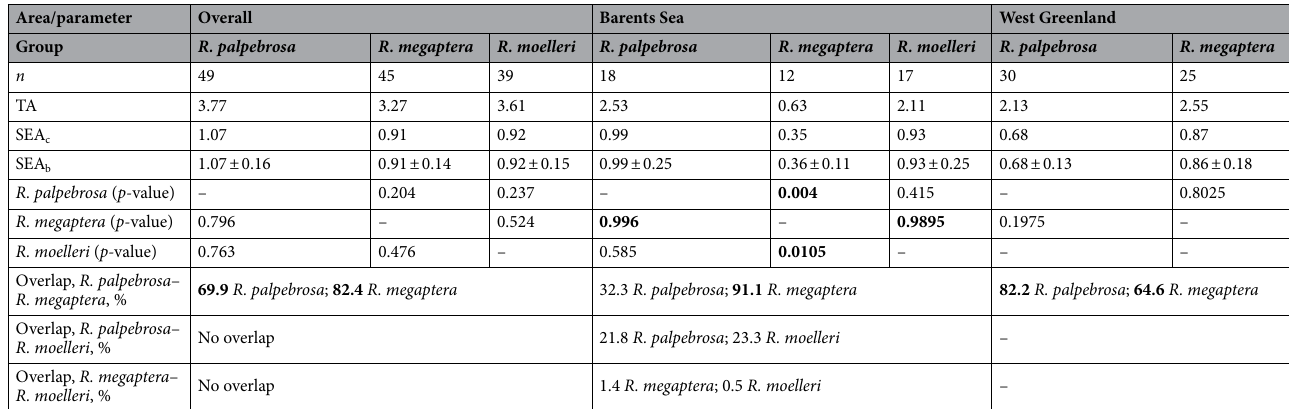
Table 3. Isotopic niche metrics (TA, SEA c and SEA b ) for the studied species of the genus Rossia in each studied area and for pooled data, and respective differences in niche widths ( p value), and niche overlap. SEA b values are means ± SD. Significant p -values and large overlap values are in